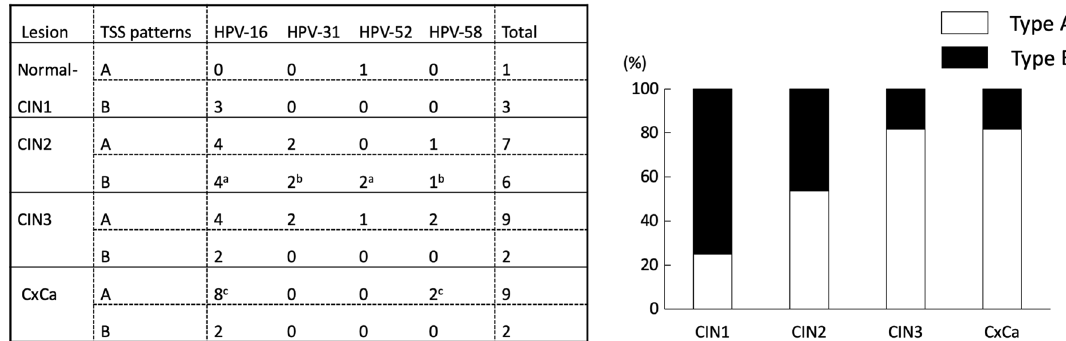
Figure 2. nAnTi-CAGE and nanoCAGE TSSs of HPV-positive cervical lesions. Thirty-nine cervical lesions with HPV-16, HPV-31, HPV-52, and/or HPV-58 infections, isolated from normal and cancerous lesions, were analysed by nAnTi-CAGE or nanoCAGE. The HPV TSS patterns were investigated and classified according to the prominent TSS types. Regardless of the HPV strain, early and late promoter activity was defined by the numbers of TSSs in each transcriptome that started either between nucleotides 80 and 110, or between nucleotides 600 and 950. The TSS patterns were defined as follows: Type A, one-third of early promoter activity ≥ late promoter activity; Type B, one-third of early promoter activity < late promoter activity. The TSS patterns of HPV-positive cervical lesions along with HPV type and cervical lesion status are summarised. a Two samples were co-infected with HPV-16 and HPV-52. b One sample was co-infected with HPV-31 and HPV-58. c One sample was co-infected with HPV-16 and HPV-58. HPV human papillomavirus; TSS transcription start site; CIN cervical intraepithelial neoplasia; CxCa cervical